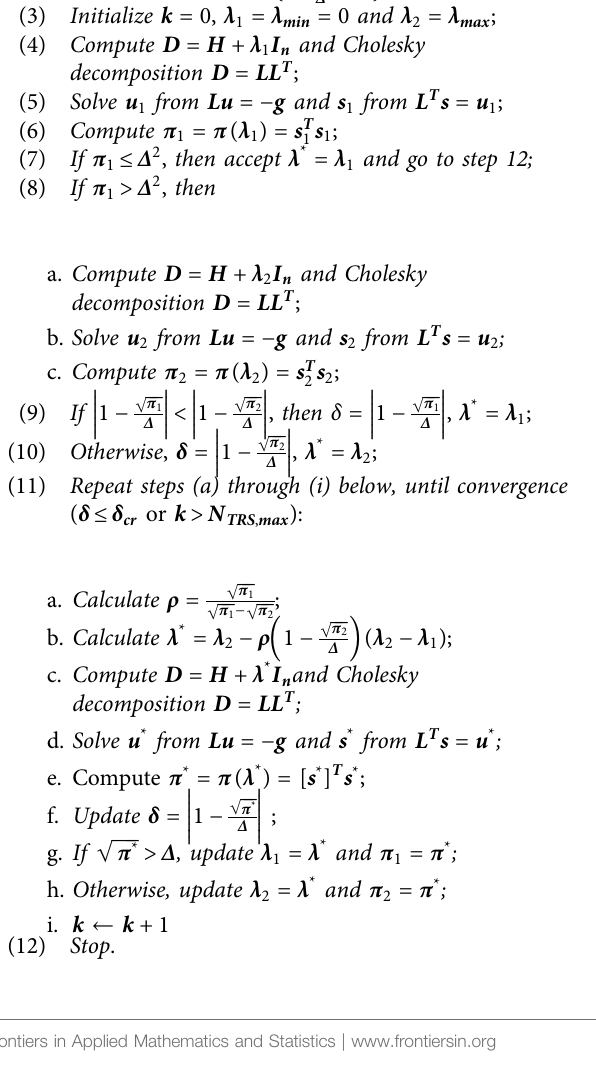
Algorithm-3: Solving the L-BFGS TRS Using the DIQ